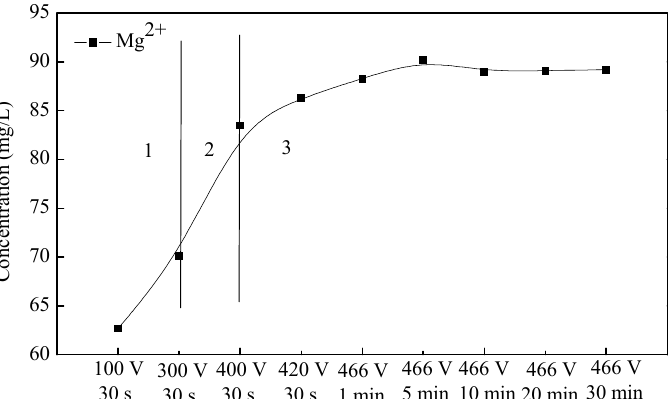
Figure 6. The changing curve of the amount of the dissolved Mg in the electrolyte during the PEO process.